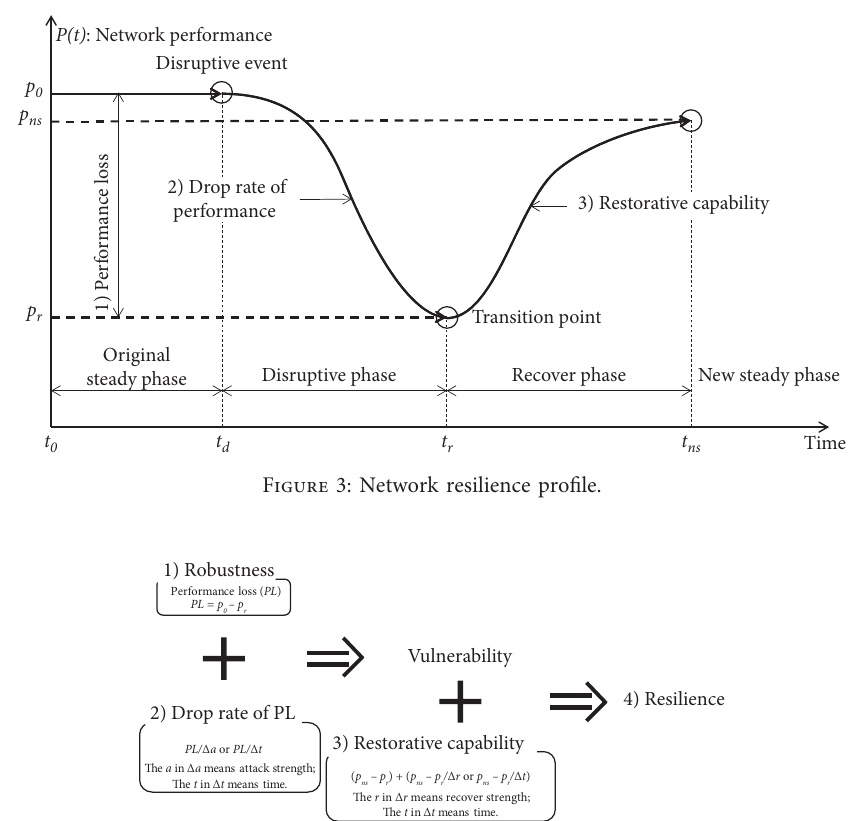
Figure 4: Illustration of relationships among resilience, vulnerability, and